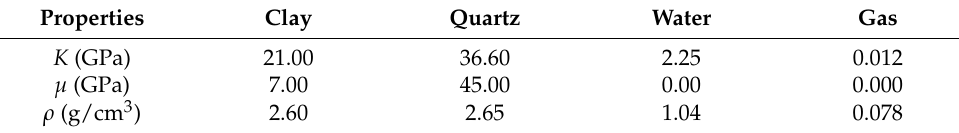
Table 1. Properties of constituents used for the rock physics modeling